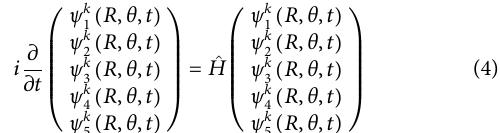
^ ^ ( 2 j + 1 ) e − En,j k V 3 ( R ) and V 4 ( R ) , and the B T is Note that the potential energy functions, n,j ^ diabatic coupling, V 34 ( R ) , are in the diabatic representation which correspond to the (1) 1 Π u and (2) 1 Π u states in the adiabatic representation. μ is the reduced mass of the Mg 2 molecule. In Eq. the ξ th electronic state. α ξ represents the dynamic electronic jj ′ polarizability. W ξξ ′ ( ξ ≠ ξ ′ ) is the coupling of states | ξ 〉 and | ξ ′ 〉 . In the two-photon rotating-wave approximation, W 12 (cid:2) ( t ) (cid:5) ϵ ϵ 2 ← 1 1 cos 2 θ represents the two-photon coupling E 2 f 2 j j ′ M j,j ′ 0 tot jj ′ 4 between states |1 〉 and |2 〉 , where M 2 ← 1 denotes the tensor element of jj ′ the two-photon electric transition dipole moment [37]. W ξξ ′ = μ ξξ ′ ( R ) E ( t ) cos θ ( ξξ ′ = 13, 14, 15, 23, 24) is the coupling via the transition dipole moment. W 13 , W 14 and W 15 are the three-photon couplings and W 23 , W 24 and W 25 are the one-photon couplings. The fi ve-state time-dependent Schrödinger equation of the Mg 2 system is shown as